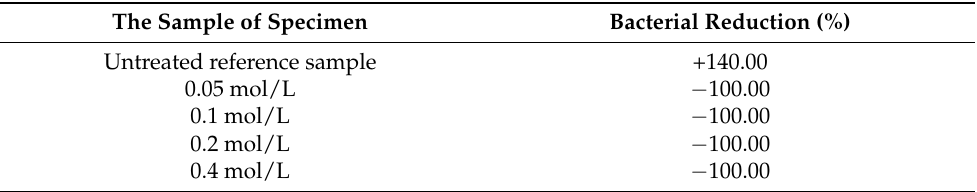
Table 3. The value of antibacterial activity of the nanosized particles against Escherichia coli bacteria after 24 h. The Sample of Specimen Bacterial Reduction (%) Untreated reference sample